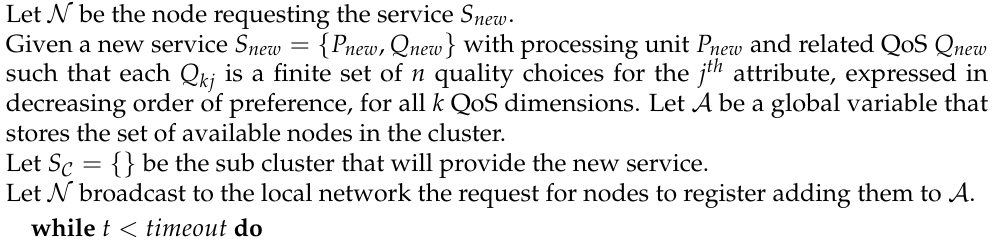
Algorithm 2 Dynamic adaptation to new services.